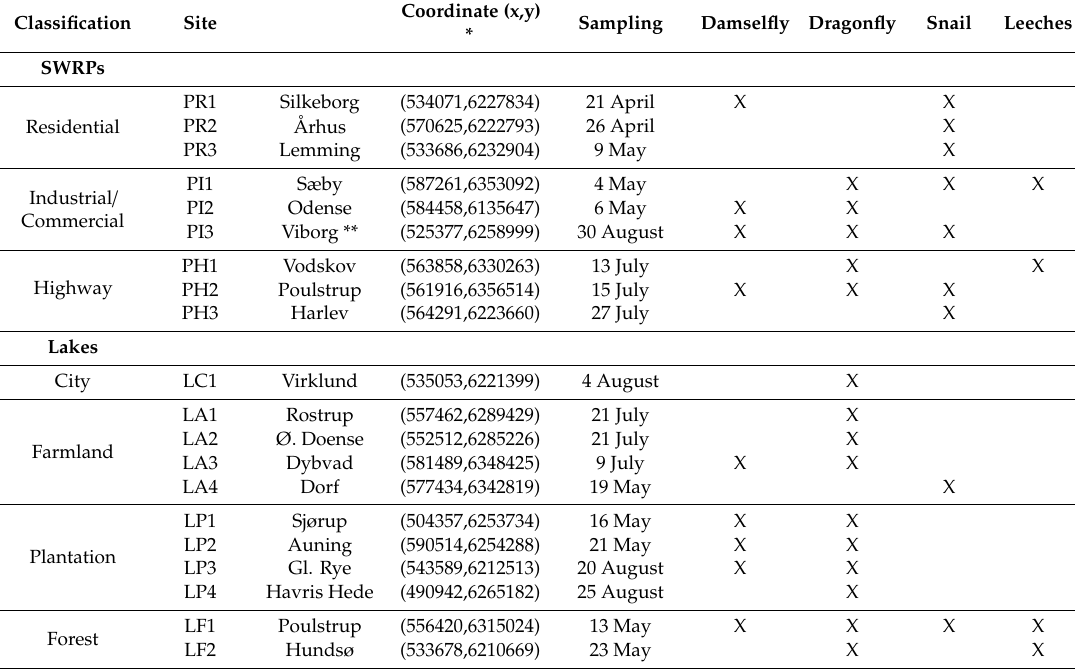
Table 1. Classification of SWRPs and natural, shallow lakes. Invertebrates taxa collected and analyzed for